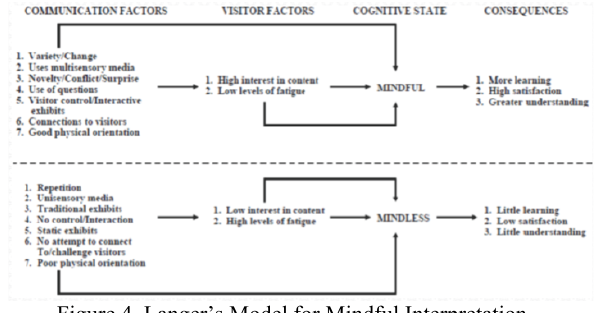
Figure 4. Langer’s Model for Mindful Interpretation